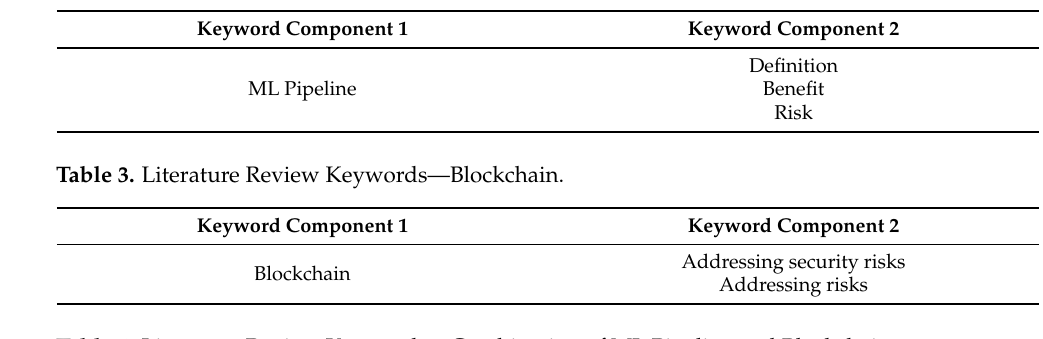
Table 4. Literature Review Keywords—Combination of ML Pipeline and